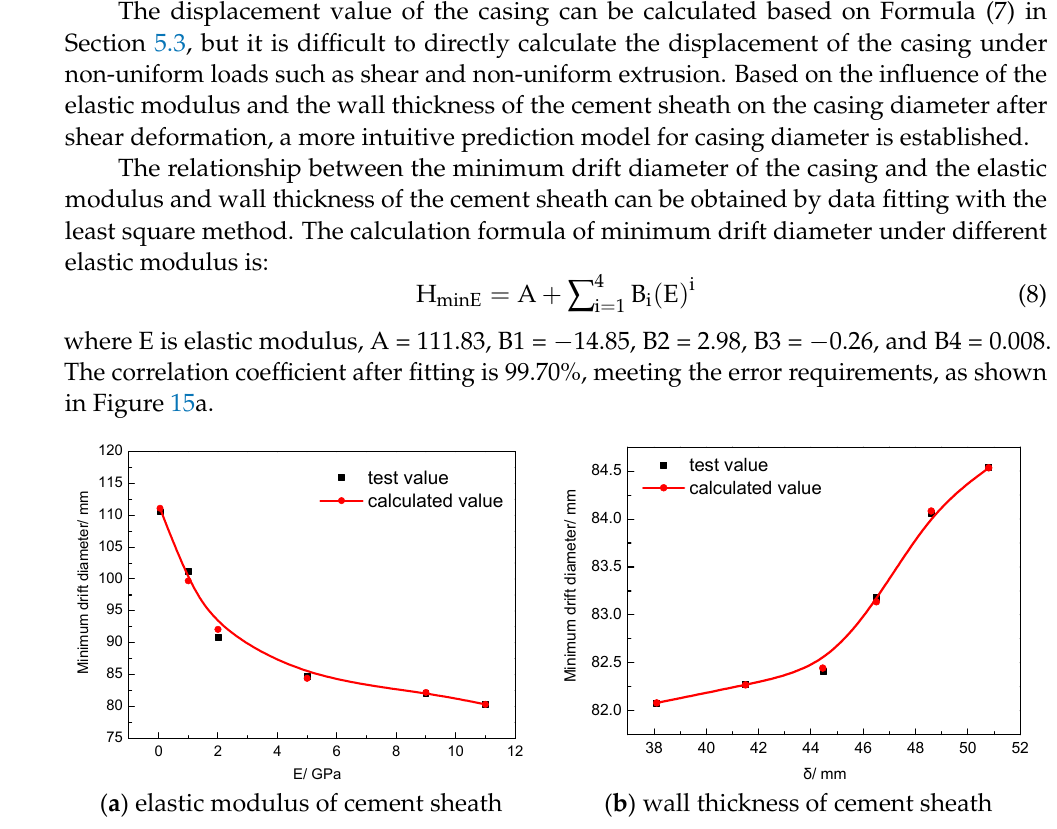
Figure 15. Relation between test value and calculated value of casing minimum drift diameter.